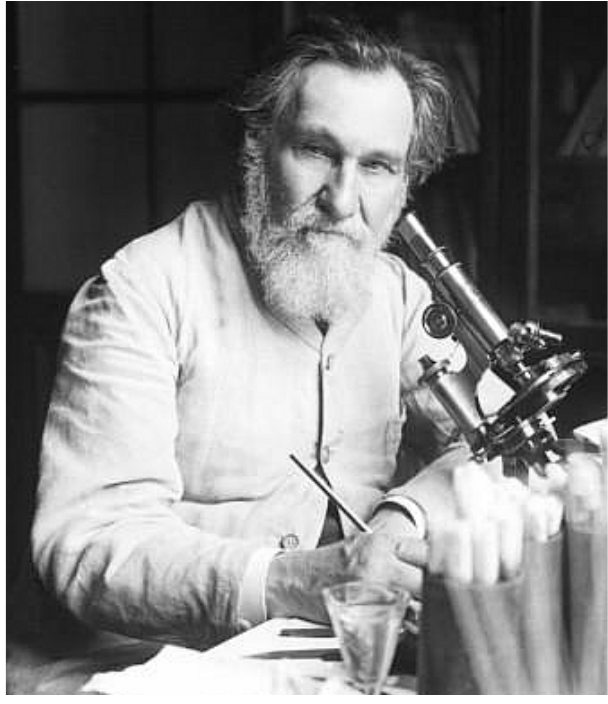
Figure 1. Ilya Ilyich